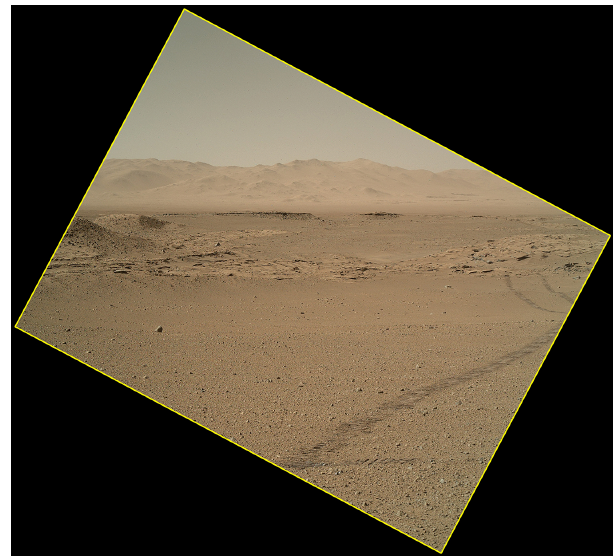
Figure 9. Example of MAHLI’s view of the landscape acquired on sol 634 (19 May 2014) when the robotic arm was in a stowed posi- tion. This view, looking toward the north wall of Gale crater (back- ground), shows the Kimberley field site and Windjana drill loca- tion (left). The outer-edge distance between the right and left wheel tracks is about 2.8m. Illuminated by sunlight from the top left, this is MAHLI image